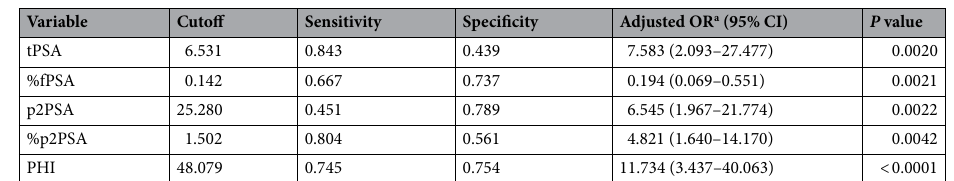
Table 4. Multivariate logistic regression analyses to predict the detection of clinically significant prostate cancer at biopsy in patients with PI-RADS 4/5 lesions. Excluding PSA density in multivariate model to avoid multi-collinearity problems. PI-RADS, Prostate Imaging Reporting and Data System; PSA, prostate-specific antigen; tPSA, total PSA; fPSA, free PSA; %fPSA, fPSA to tPSA ratio; p2PSA, [-2]pro PSA; %p2PSA, p2PSA to fPSA ratio; PHI, Prostate Health Index; OR, odds ratio; CI, confidence interval. a Adjusted for age, prostate volume, previous negative biopsy and abnormal digital rectal examination.